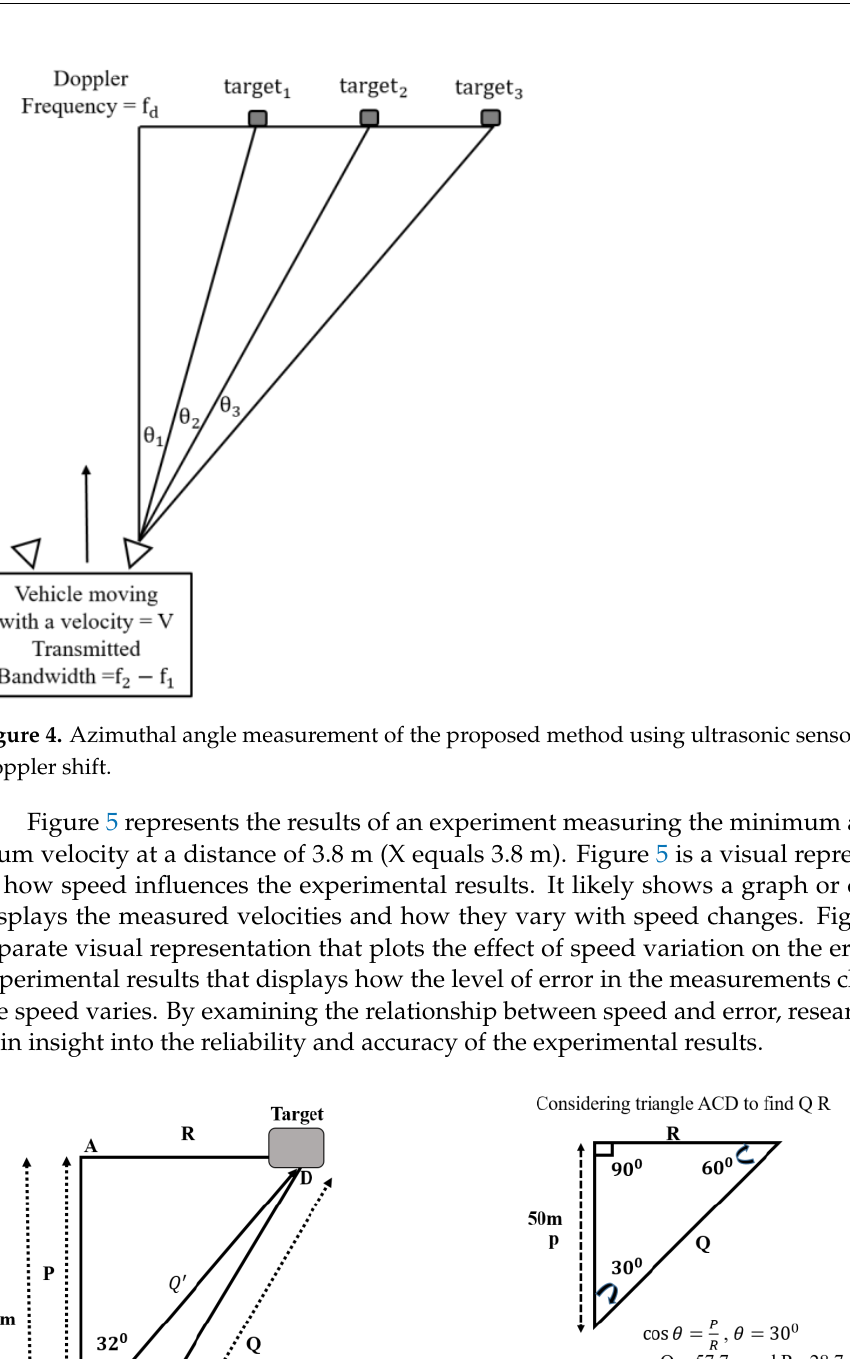
Figure 6. Representation of the analysis of the influence of the speed variation vs. error in degrees. Figure 7 depicts the real-time implementation of the proposed technique for estimat- ing the azimuthal angle of objects using ultrasonic sensors and the Doppler frequency shift. This method involves generating a signal with a frequency of 40 kHz and a voltage of 5V_pp using the DAQ and transmitting it to the ultrasonic transmitter as part of the experiment. The echo signal received by the sensor from each of the objects located under a single beam is then processed to determine the angle of incidence, called the azimuthal angle. Figure 8 depicts the Doppler frequency shift of the received signal from the objects as DAQ acquired it in the time domain. This frequency shift may be attributed to the num- ber of objects under a single beam. After that, the signal is processed to estimate the ob- jects’ azimuthal angles accomplished by first transforming the signal into the frequency domain by applying the FFT. Then, the signal is processed to calculate the angle. After applying FFT to the data collected from DAQ in the time domain, Figure 9 dis- plays the Doppler frequency shift in the frequency domain. Figure 9 shows the proposed method successfully identifying 2 objects by indicating the 2 Doppler frequency shifts at different frequency peaks due to the Doppler Effect, which corresponds to the 2 objects placed at 35 0 and 50 0 , respectively. Utilizing a methodology similar to that described above, we investigated using 3 objects oriented at angles of 20 0 , 35 0 , and 50 0 , respec- tively. As illustrated in Figure 10, we first acquired the data in the time domain employing DAQ. Furthermore, we performed the FFT using signal processing to determine the